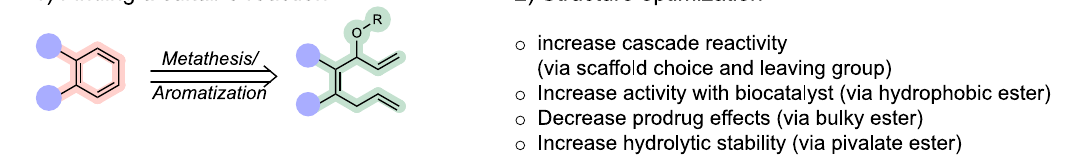
Fig. 1 Directions in prodrug design. a General categorization of prodrug types can be made via their activation pathway, which are either naturally- or externally-triggered. This study aims to develop a working example of a synthetic prodrug. b Retrosynthetic prodrug design is a concept that aims to design prodrugs that transform into bioactive molecules via a bond-forming reaction. The proposed synthetic prodrug design relies on a sequential RCM/ aromatization reaction to construct phenyl-containing bioactive